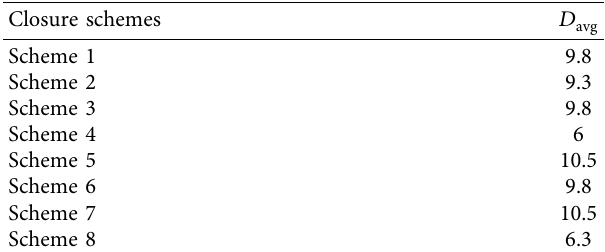
Table 6: Average defection of each closure scheme in the bridge state (mm).